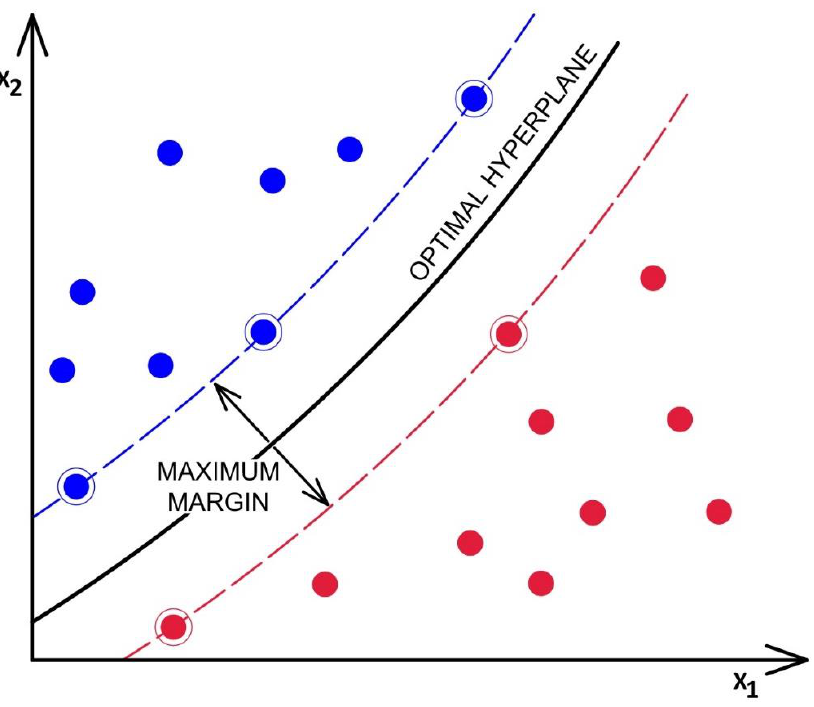
Figure 3. Optimal hyperplane of an Support Vector Machine algorithm.